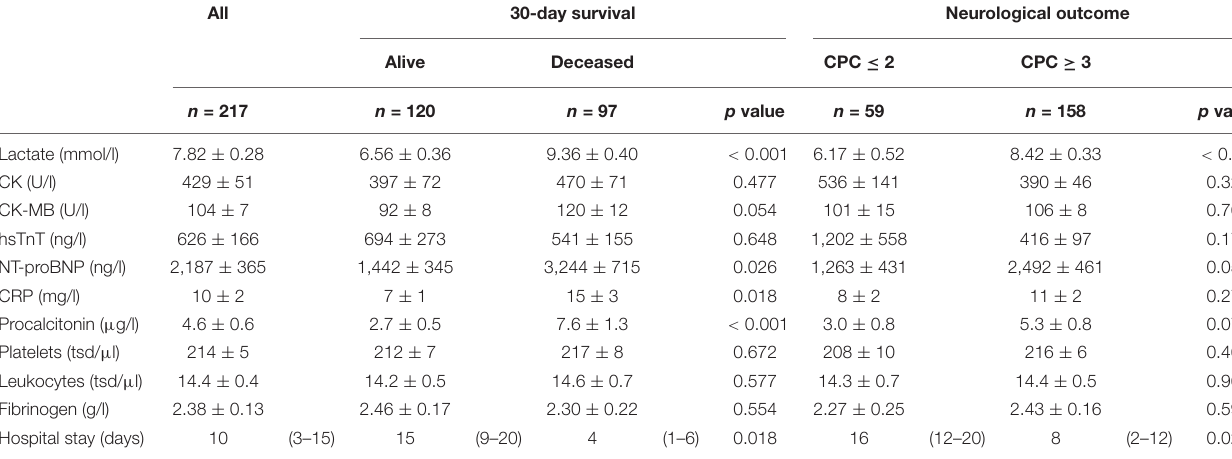
lowest IL-6 value to predict good neurological outcome with a 100% specificity was 21 ng/l and highest value to predict poor outcome with a 100% specificity was 682